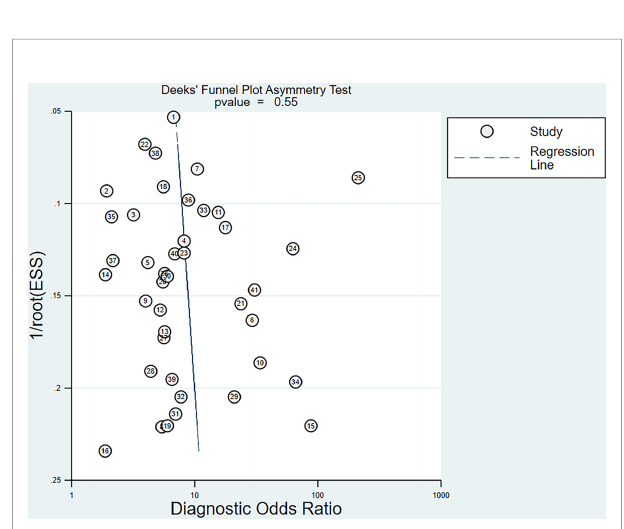
FIGURE 6 | Funnel plot of the reciprocal of effective sample size (ESS) plotted on the y-axis against the diagnostic odds ratio plotted on the x-axis. The regression line is used as a measure of asymmetry. The circles represent included